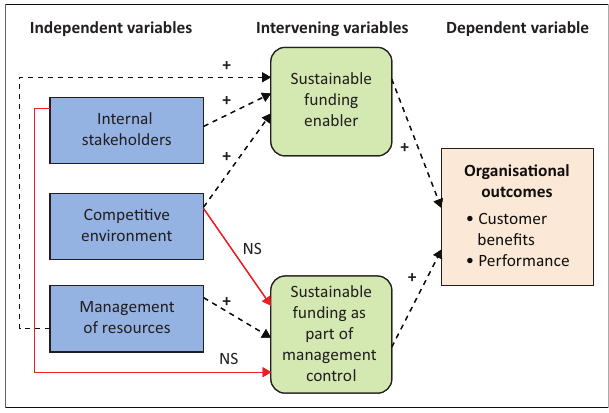
FIGURE 2: The proposed sustainable funding framework for the public broadcaster in South